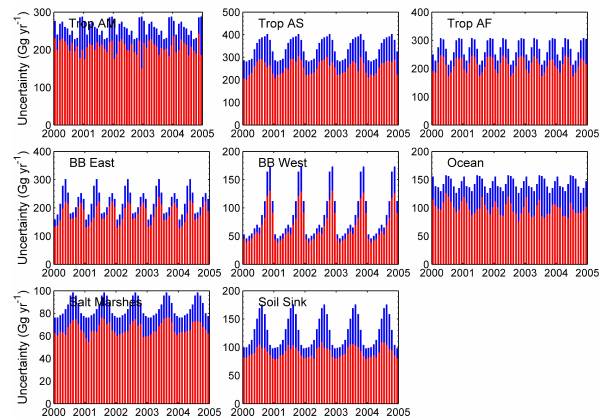
Fig. 6. Inversion results for the eight seasonally varying processes for emissions of CH 3 Cl. Blue lines show the reference magnitudes, which are annually repeating. Red lines show the optimized esti- mates, which show interannual variability. The total value is the sum of the emissions from the eight seasonal processes, the as- sumed time invariant aseasonal fungal emissions, and the reference industrial and wetland emissions.